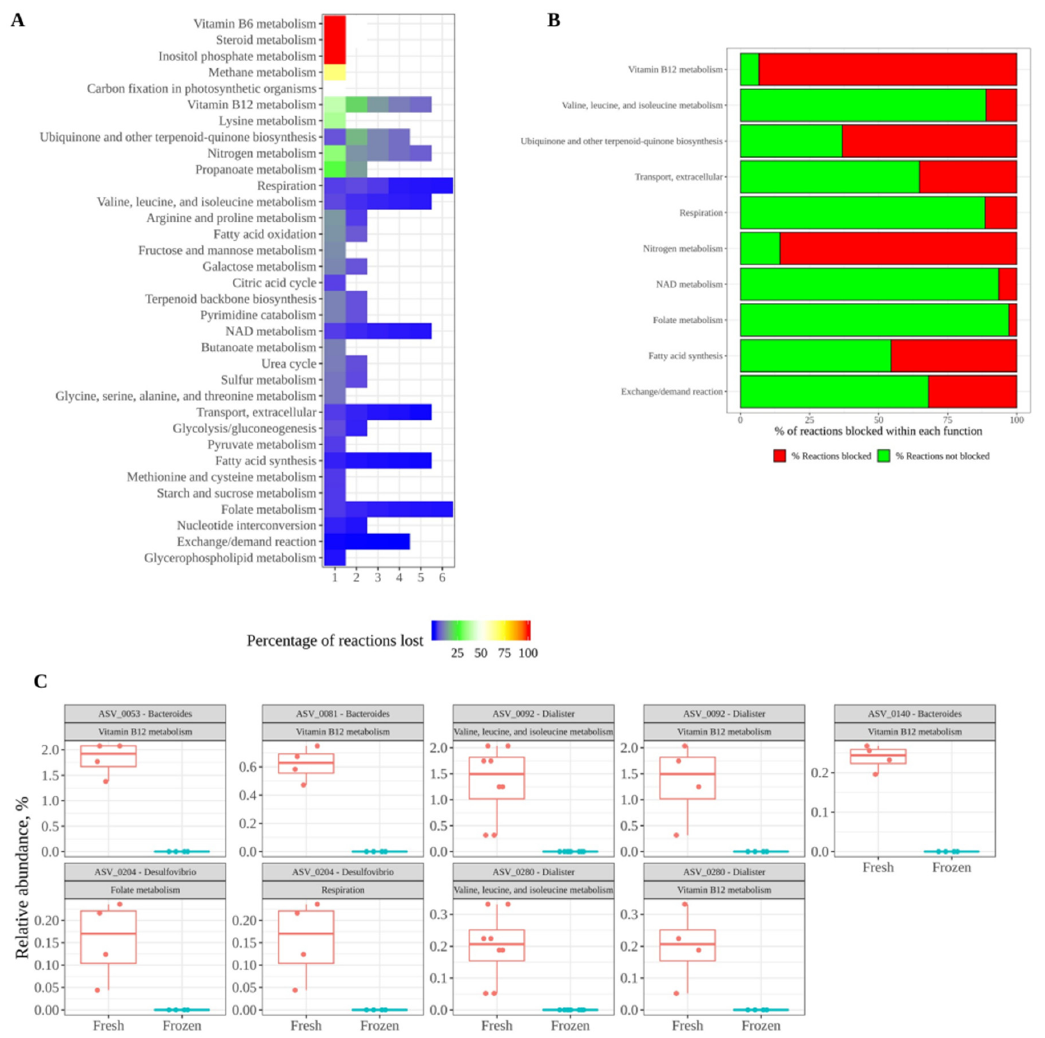
Figure 6. ( A ) shows a heatmap of the percentage of reactions that are present in fresh samples but not in frozen samples over the course of the stabilization days; ( B ) shows the percentage of reactions that are blocked in each function as a consequence of the reactions lost on day 5; ( C ) shows the microbes related to lost functions and how they were present in fresh samples but not in frozen samples.